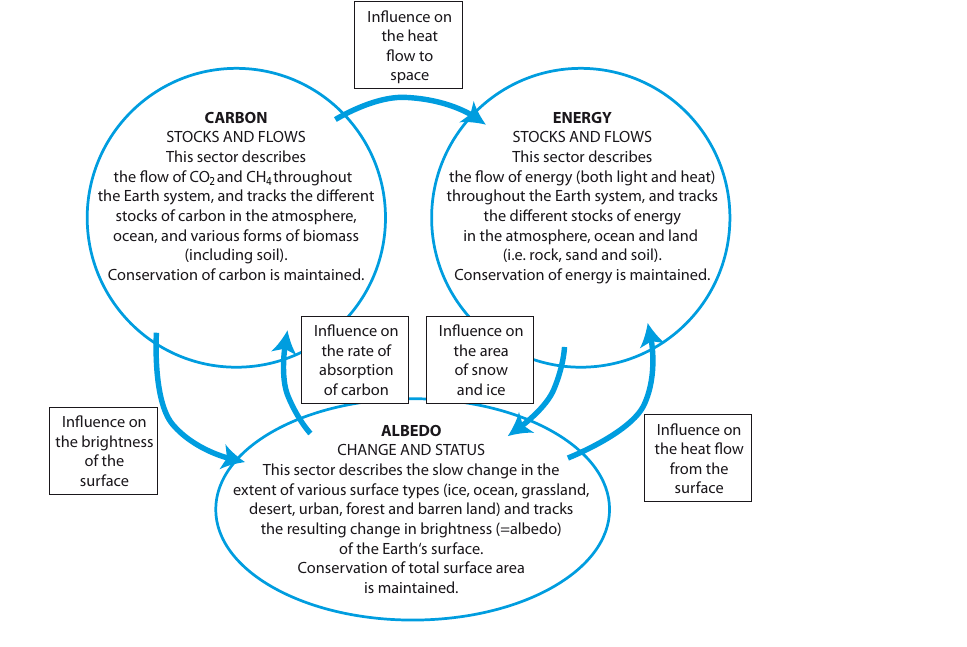
Figure 1. The three sectors in